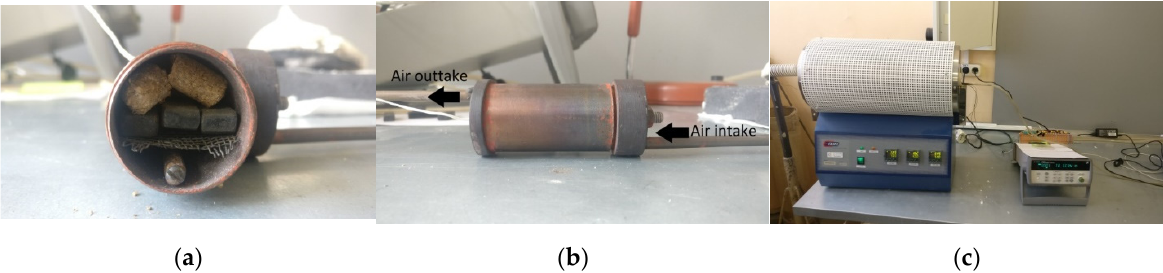
Figure 4. ( a ) Coated samples in the experimental cylinder with straw pellets, ( b ) metal cylinder with the samples, ( c ) experimental setup.